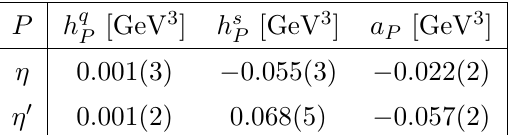
, h q and h s relies on the so-called Feldmann- (cid:17) ( 0 ) (cid:17) ( 0 ) (cid:17) ( 0 ) (cid:17) = ( u (cid:22) u + d (cid:22) d ) = p 2 and (cid:17) = s (cid:22) s only mix through the q s j i j j i j i j i